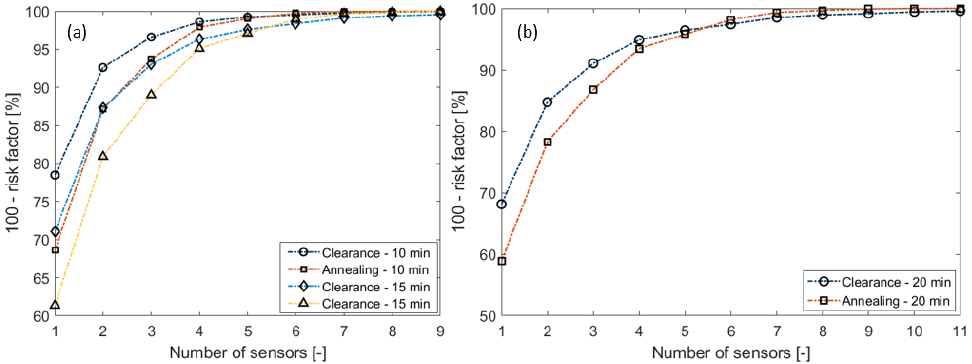
Figure 8. The safety factors for clearance and annealing as a function of the sensor number: ( a ) for the sampling frequency of 10 and 15 minutes; ( b ) for the sampling frequency of 20 minutes [16].